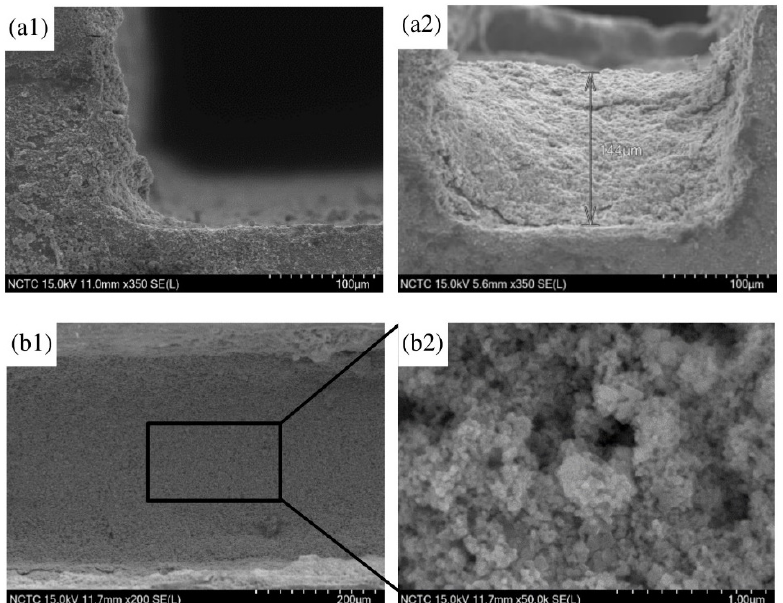
Figure 3. Photograph and surface morphology of the micro-channel plates: ( a1 ) ×200 and ( a2 ) ×1000 before cleansing; ( b1 ) ×200 and ( b2 ) ×1000 after cleansing, with 20% citric acid; ( c1 ) ×70 and ( c2 ) ×50,000 after annealing at 800 °C.